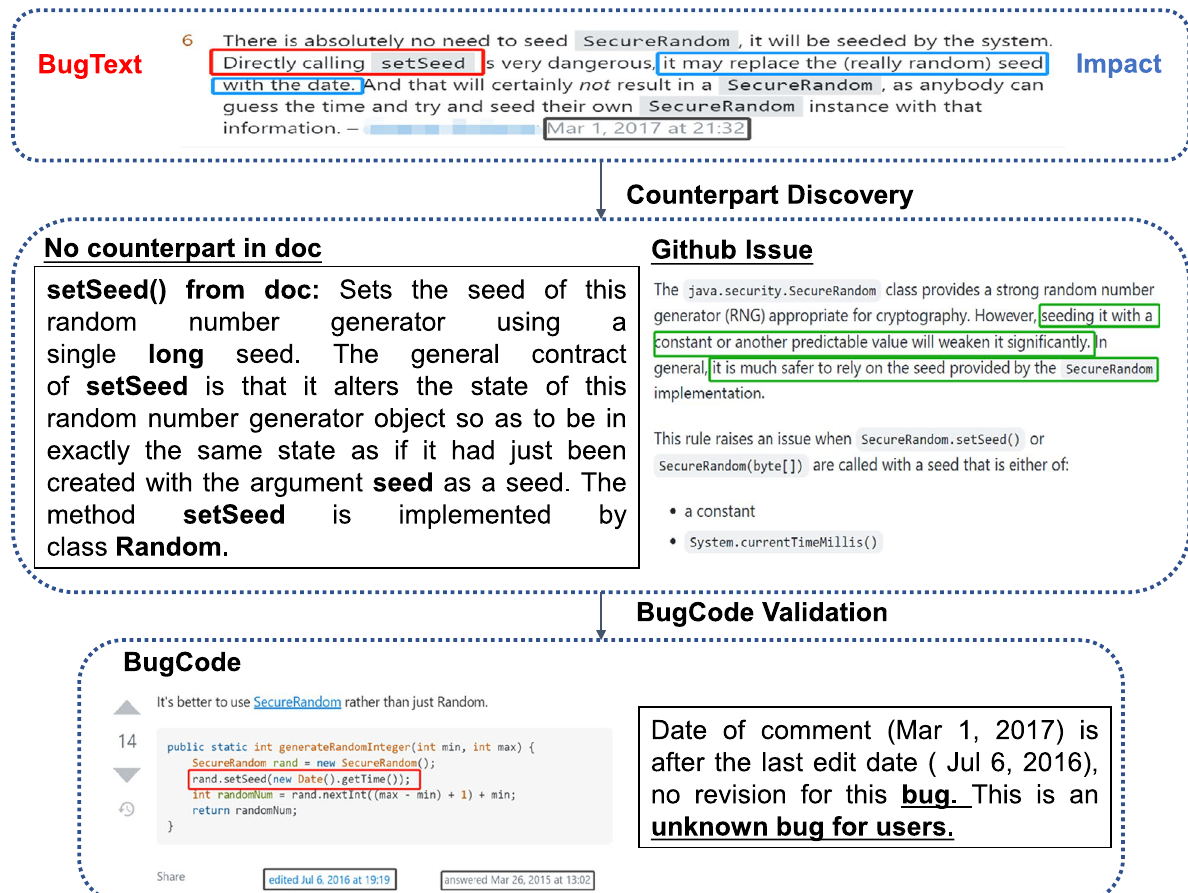
Fig. 9 The API-selection case for counterpart discovery and unknown bug discovery and